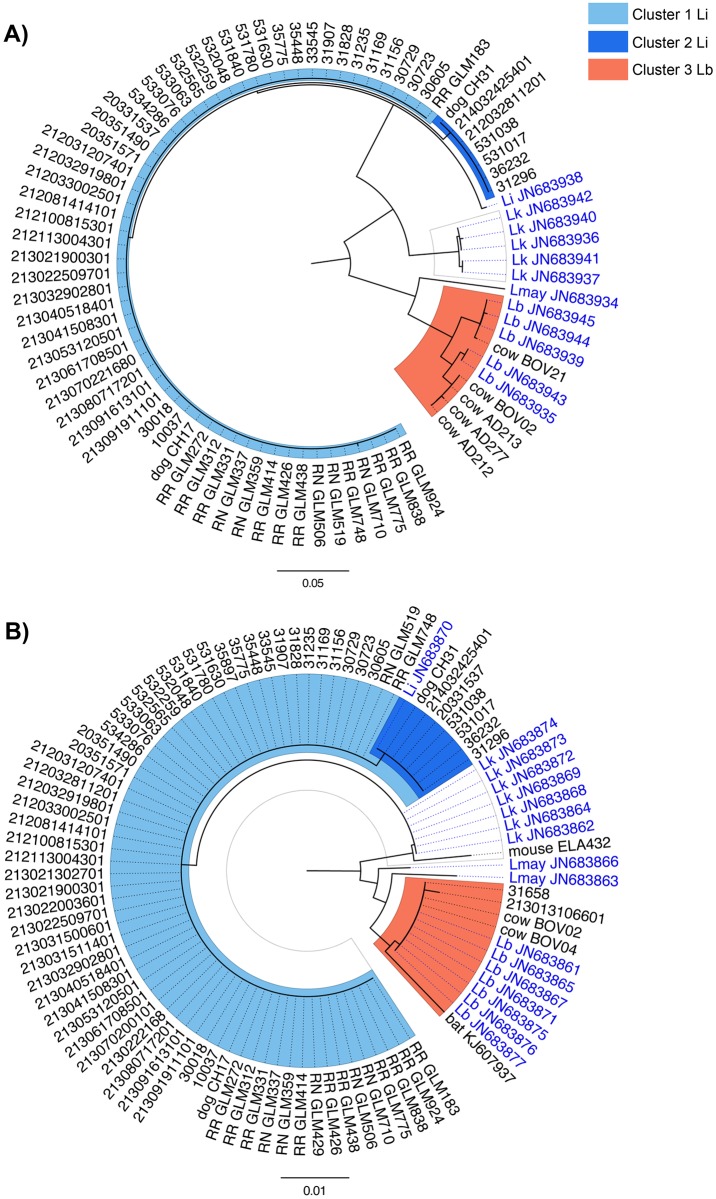
Neighbour-joining phylogenetic trees (Kimura’s 2-parameter distances, 500 replicates) inferred from (A) secY (501 bp sequence) and (B) rrs2 (450 bp sequence) genes.Clinical and animal samples from Reunion Island are written in black, using GenBank accession numbers (for one published bat sequence) or identifiers accompanied by the host name in the case of animal samples (RR: Rattus rattus; RN: Rattus norvegicus). Corresponding GenBank accession are reported on S1 Table (supporting information). Clinical samples from Mayotte are written in blue, using GenBank accession numbers and corresponding Leptospira species. Li: Leptospira interrogans; Lb: Leptospira borgpetersenii; Lk: Leptospira kirschneri; Lmay: Leptospira mayottensis.